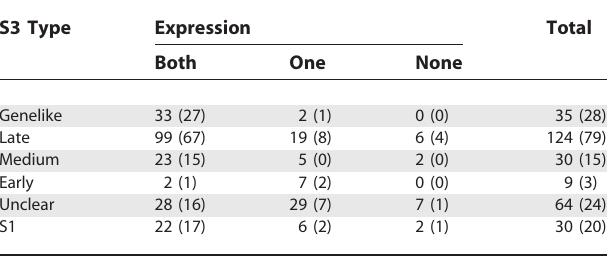
Table 4. Human and Mouse Expression for 262 S3 Quartets Selected as Described in Table 1